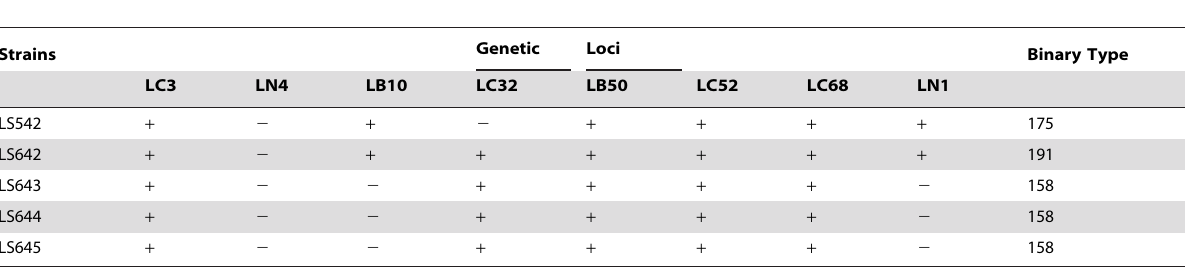
+ / 2 indicates presence/absence of band.